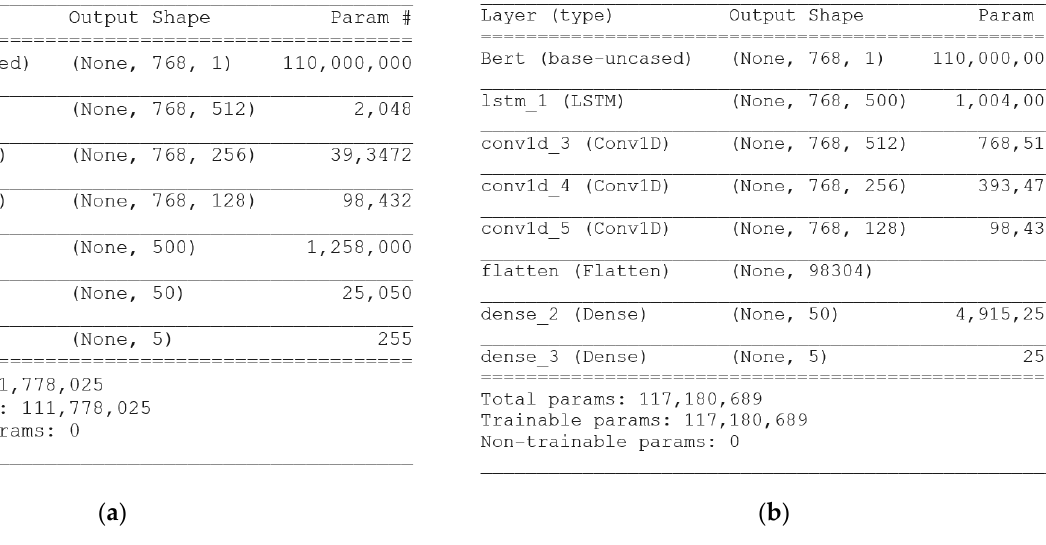
Figure 3. Visualization of the hybrid models: ( a ) hybrid CNN–LSTM (Convolutional Neural Networks Long Short-Term Memory) model in the first panel; ( b ) hybrid LSTM–CNN model in the second